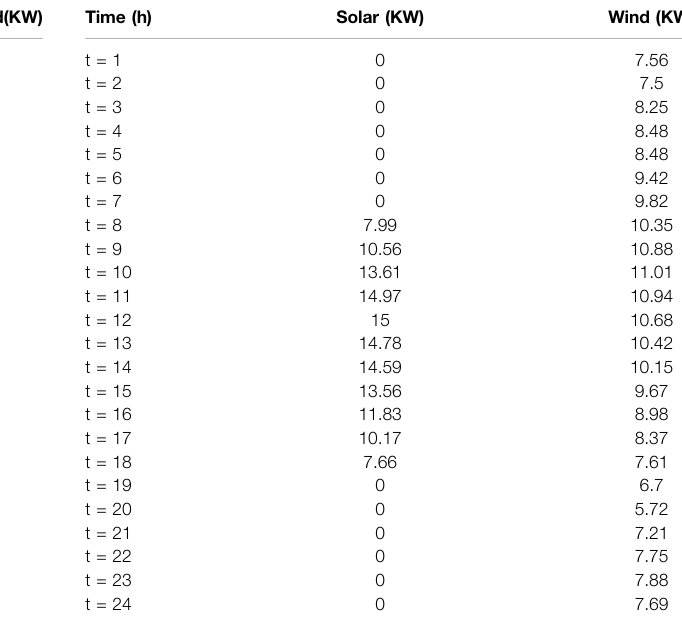
TABLE 3 | λ i,t values and total initial hourly demand (case study 1). TABLE 4 | Forecasted power from solar PV and wind generators (case study